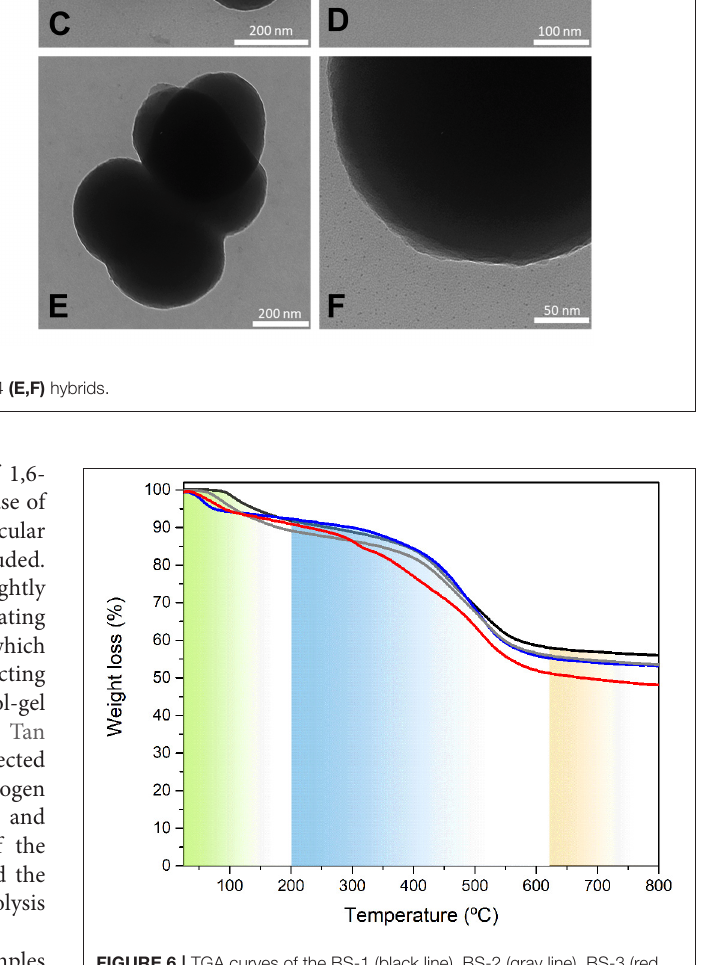
FIGURE 6 | TGA curves of the BS-1 (black line), BS-2 (gray line), BS-3 (red line), and BS-4 (blue line)